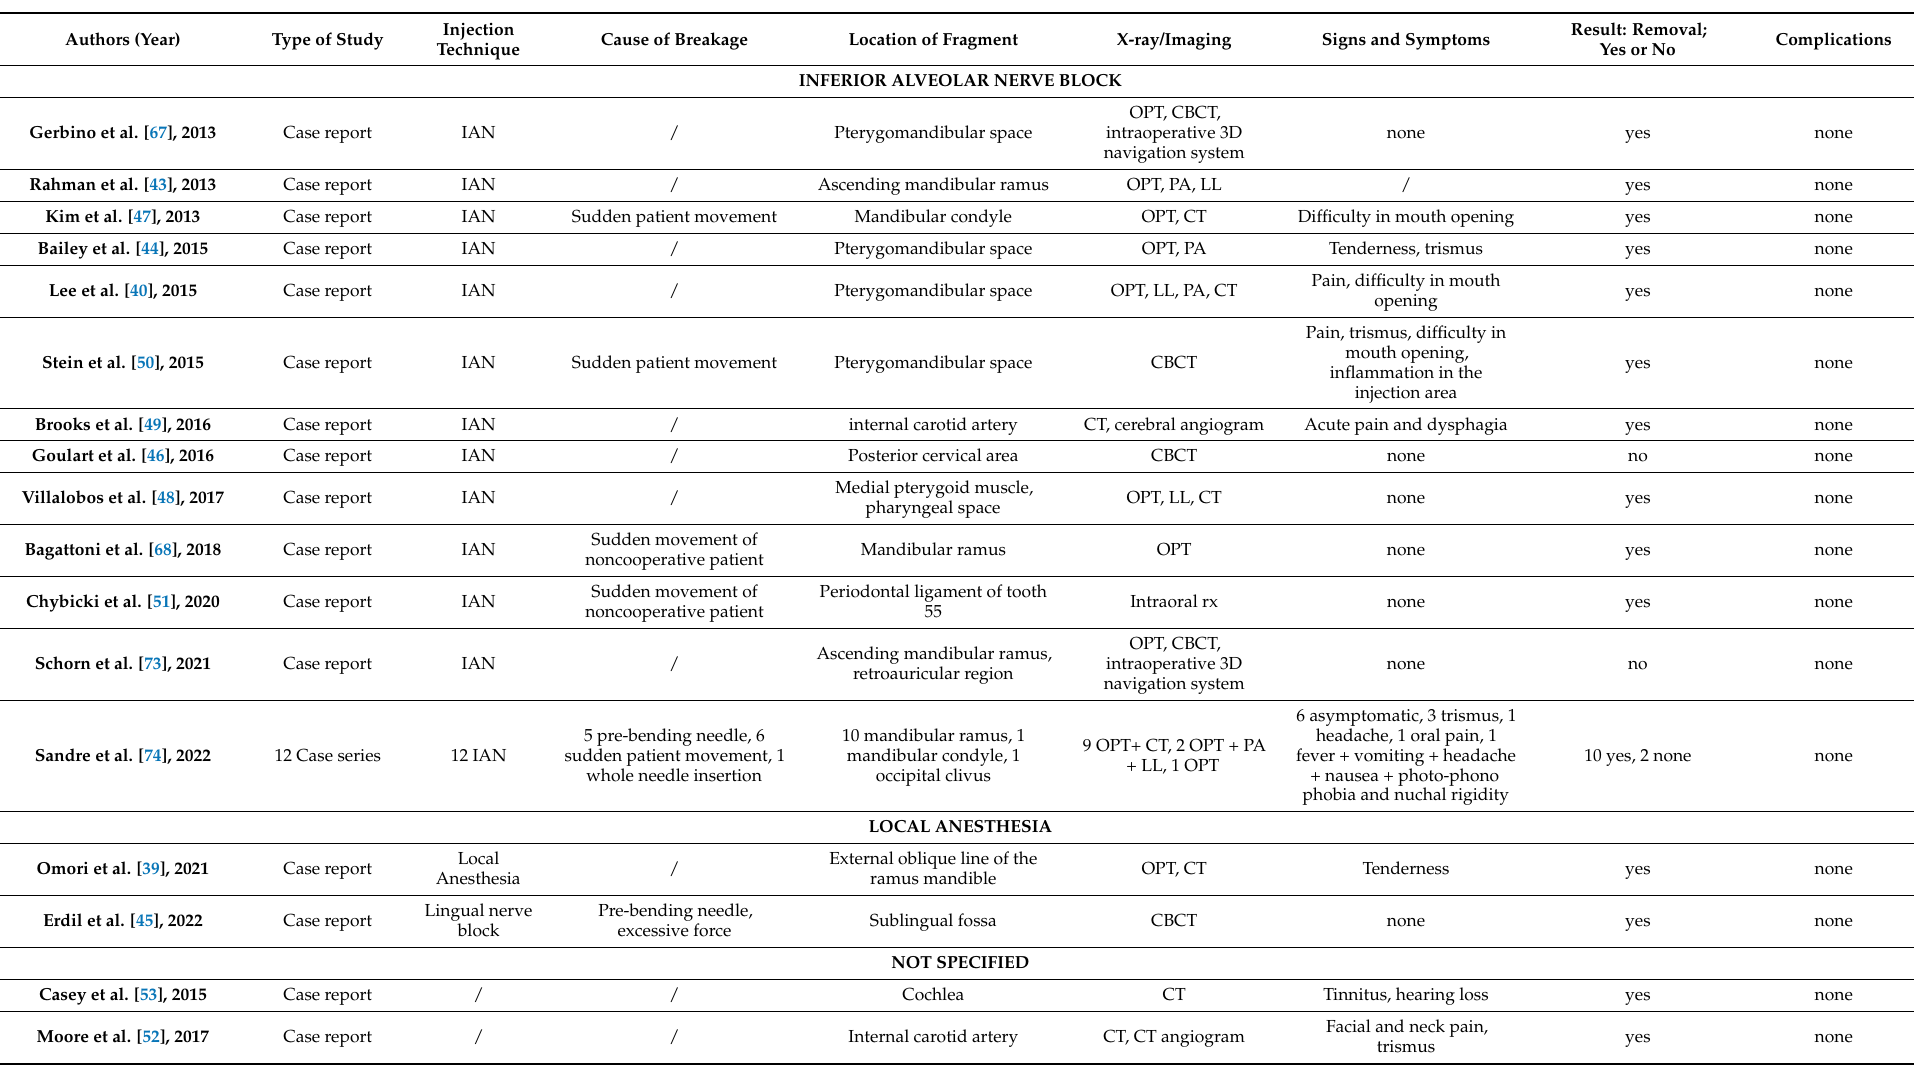
Table 1. Studies included for qualitative